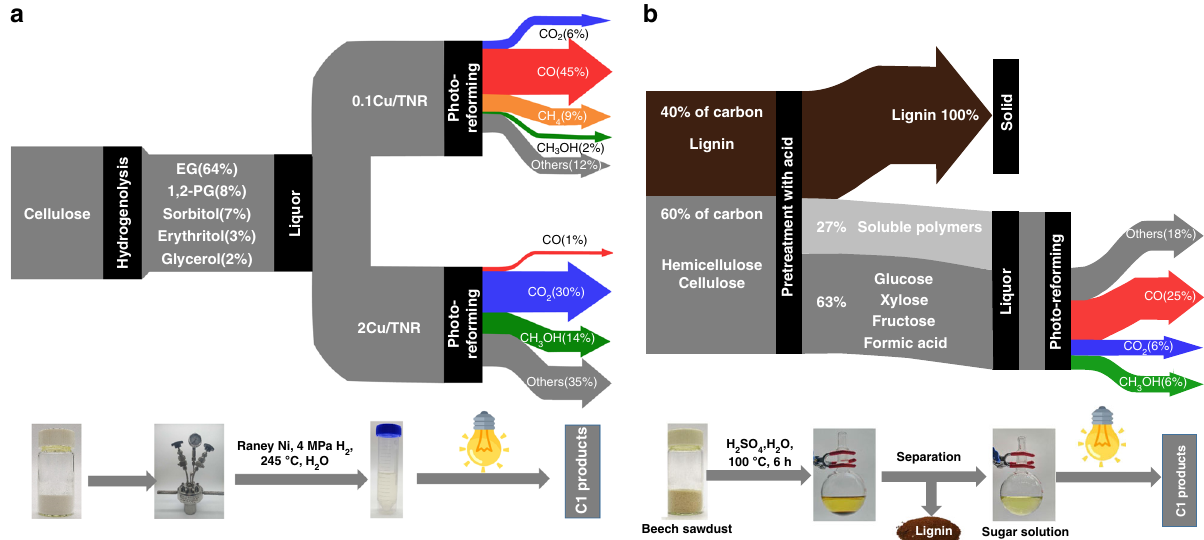
Fig. 4 Two-step strategy for the conversion of cellulose and sawdust into methanol and syngas. a Cellulose b beech sawdust. Detailed reaction conditions and product analysis are presented in Supplementary Tables 5,